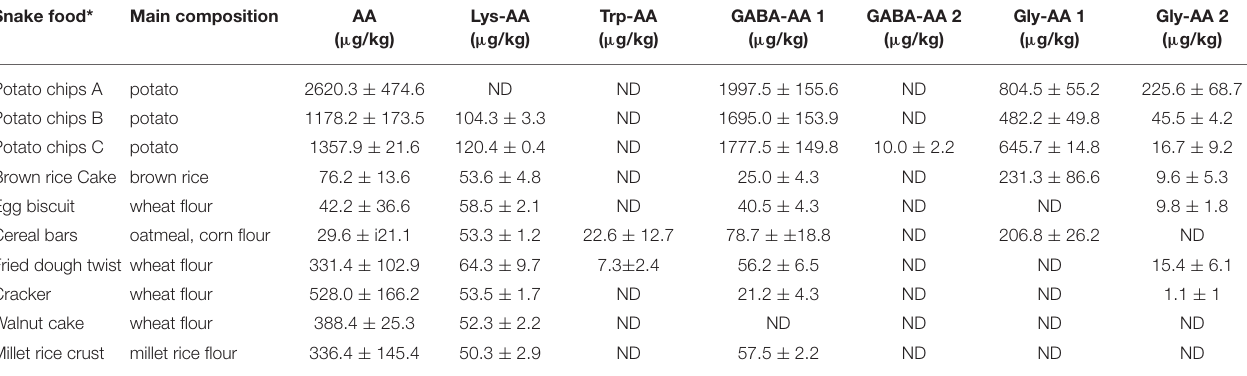
TABLE 11 | The content of acrylamide and adducts in foods. Snake